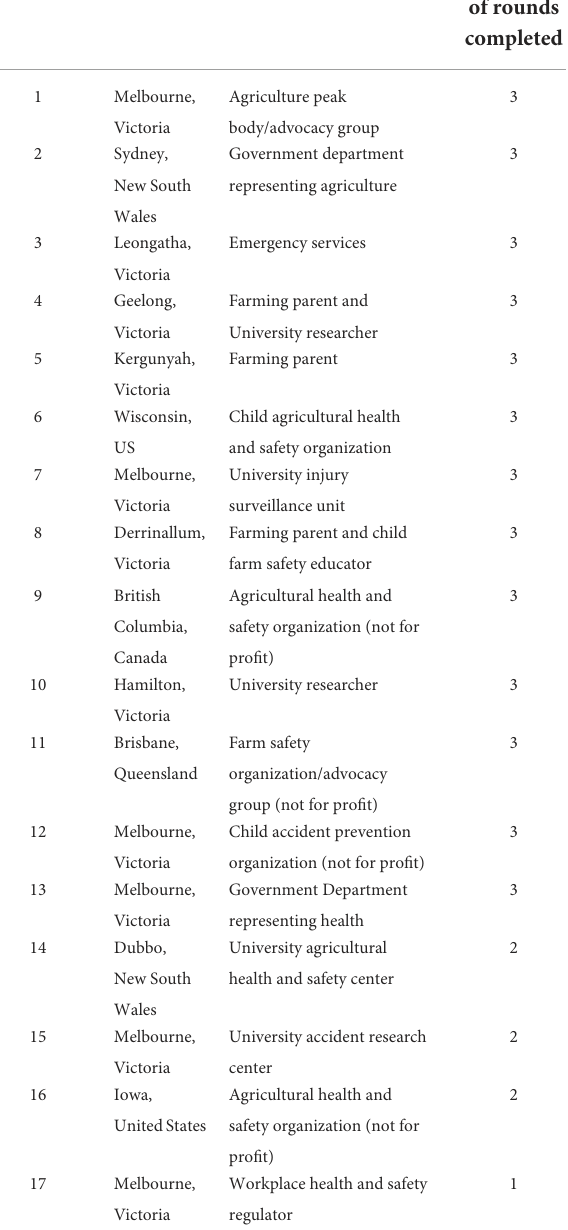
TABLE 1 Panel participants in the modified Delphi